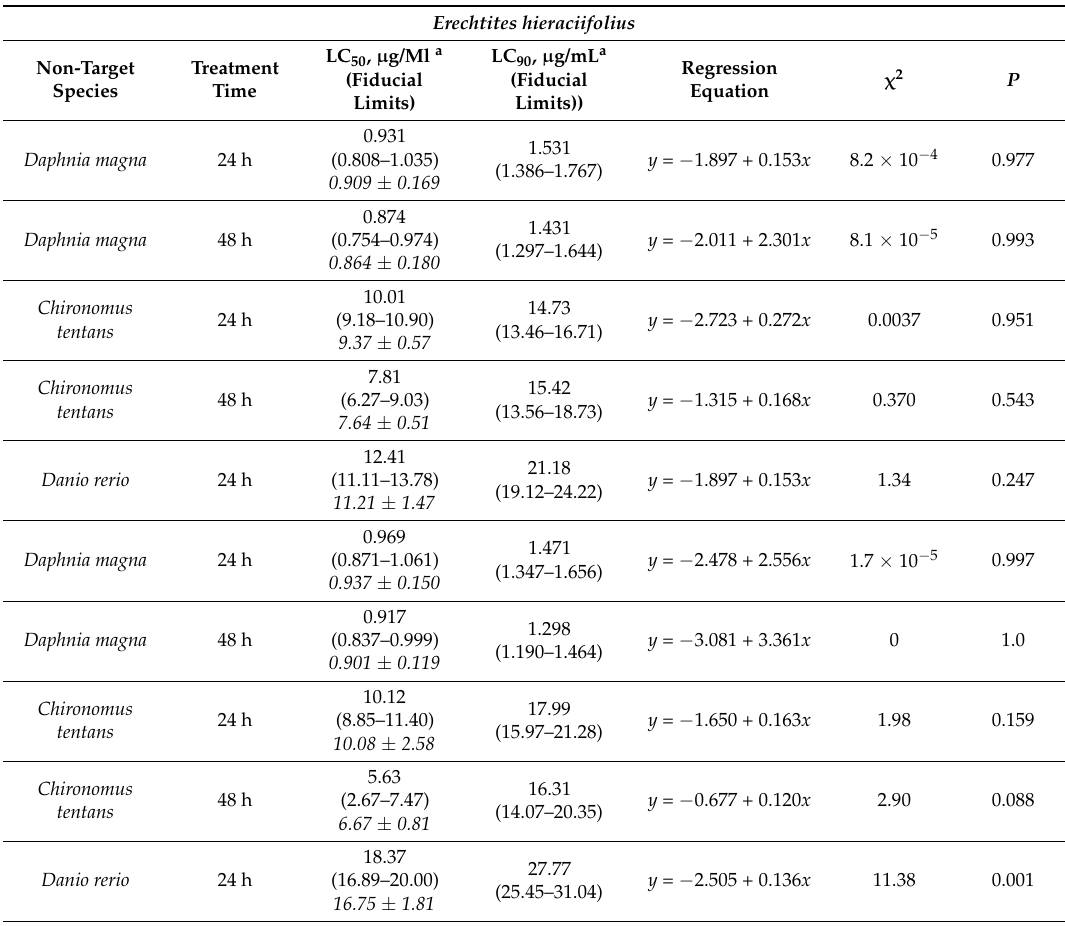
Table 8. Non-target lethality (LC 50 , µ g/mL) of Erechtites hieraciifolius and Erechtites valerianifolius aerial parts (leaves and stems) essential